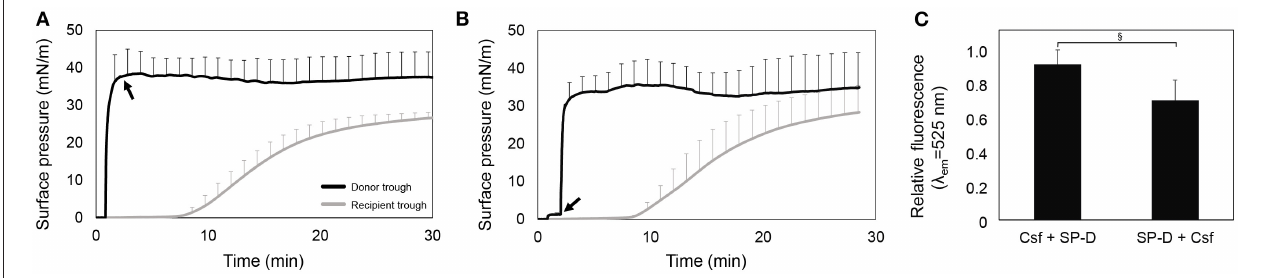
FIGURE 3 | rhSP-D conjugated with Alexa Fluor 488 transported over the interface by the association with Curosurf (Csf). (A) Adsorption and spreading isotherm obtained from the interfacial injection of 50 µ L (80 mg/mL; 4mg) of Curosurf and, 70s after, 15 µ L (1 mg/mL; 15 µ g) of F-rhSP-D (black arrow), measured in the double-Langmuir balance. (B) Pressure-time isotherm upon injection of, first, F-rhSP-D and, 70s after, Curosurf (black arrow), in a double-Langmuir balance. (C) Relative fluorescence emission at λ em = 525nm of the material collected from the recipient interface by aspiration at the end of each experiment. Data represent mean and standard deviation calculated from three different experiments. Pair t -test: (§) p = 0.078.